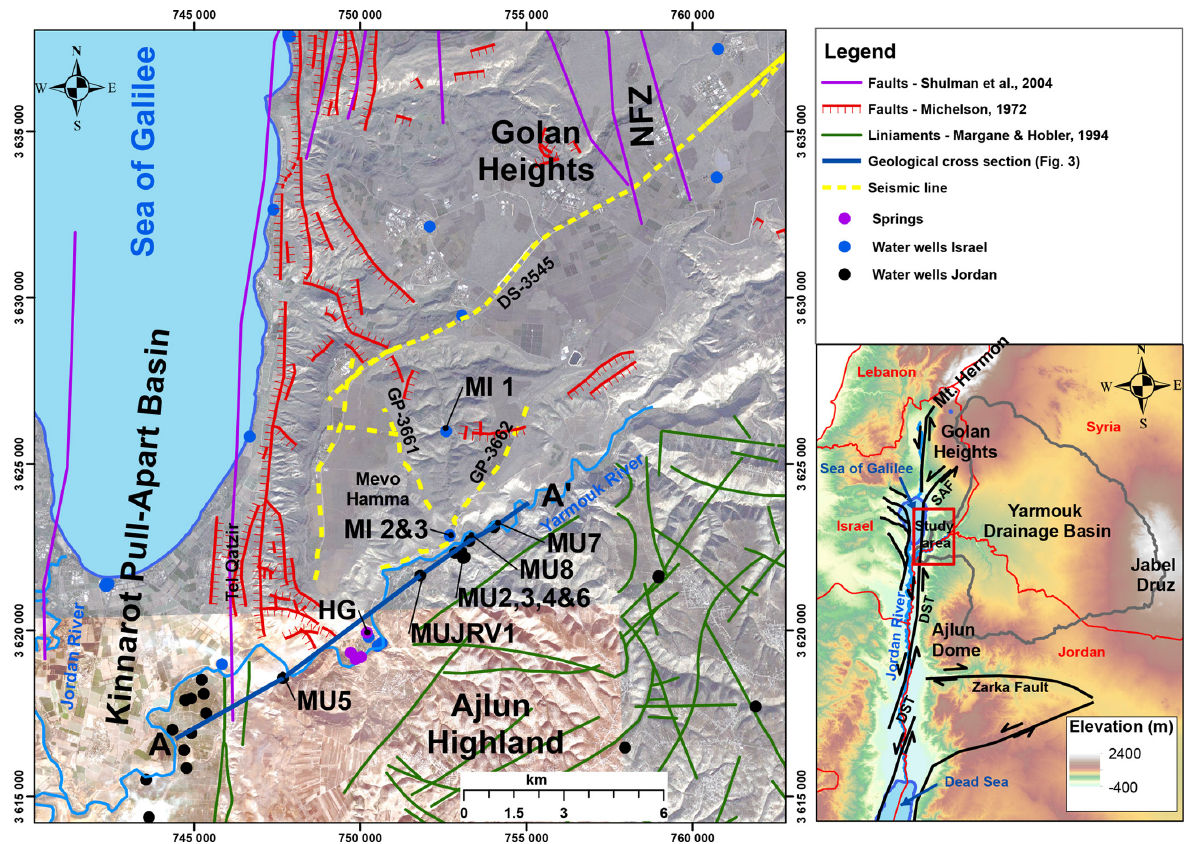
Figure 1. Regional location map on top of a digital elevation model, presenting the faults at the eastern rim of the Dead Sea Transform (DST), Sheikh Ali Fault (SAF), Nov Fault Zone (NFZ), wells belonging to Meizar (MI) and Mukheibeh (MU), and the location of the Hammat Gader (HG) springs. The locations of seismic lines (DS-3543 and GP-3662; Fig. 2) and of a geotectonic cross section along the LYG (A–A’; Fig. 3) are indicated as